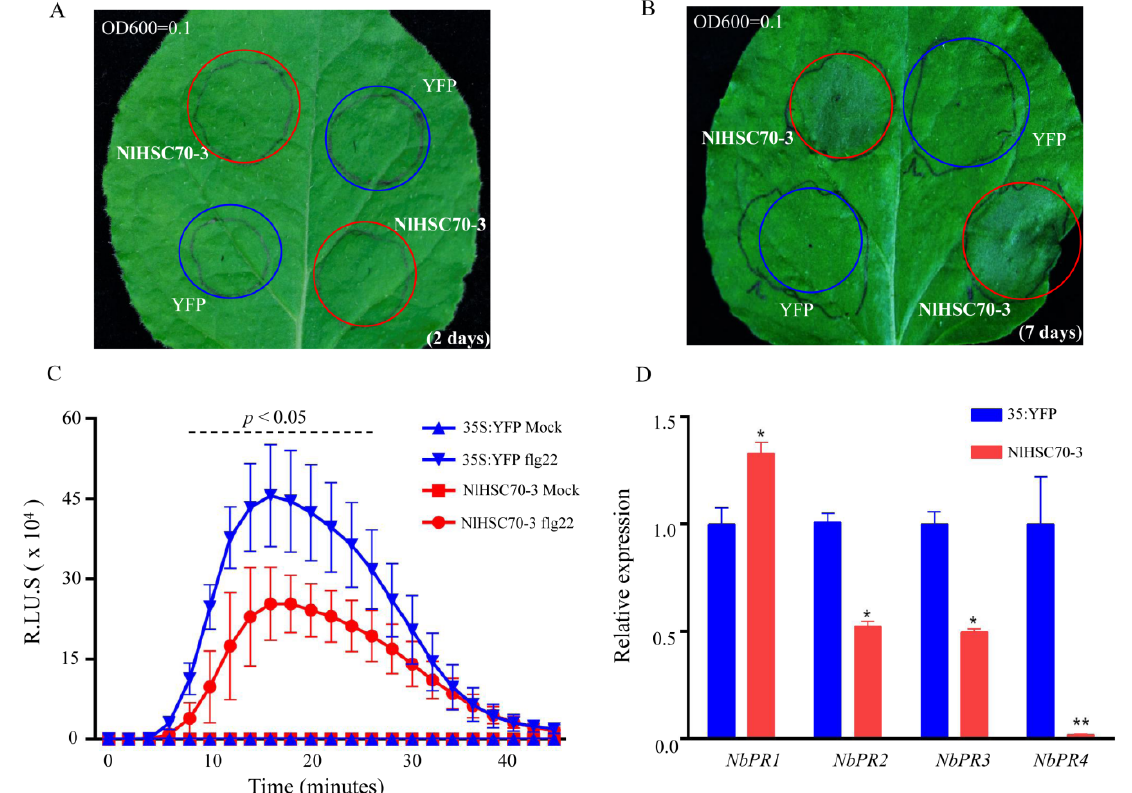
Figure 5. Defense responses are compromised by NlHSC70-3 in N. benthamiana . ( A , B ) NlHSC70-3 caused cell death at 2 days and 7 days, respectively. Leaves of N. benthamiana were infiltrated with A. tumefaciens carrying YFP and NlHSC70-3 . ( C ) The flg22-induced ROS burst is suppressed by NlHSC70-3. ( D ) Relative expression of the defense-related genes NbPR1 , NbPR2 , NbPR3 and NbPR4 inhibited by NlHSC70-3. Data were analyzed by two-tailed Student’s t -test. Data are mean ± s.d. ( n = 3 biologically independent samples). p < 0.05 was considered statistically significant (*), and p < 0.01 was considered statistically significant (**).